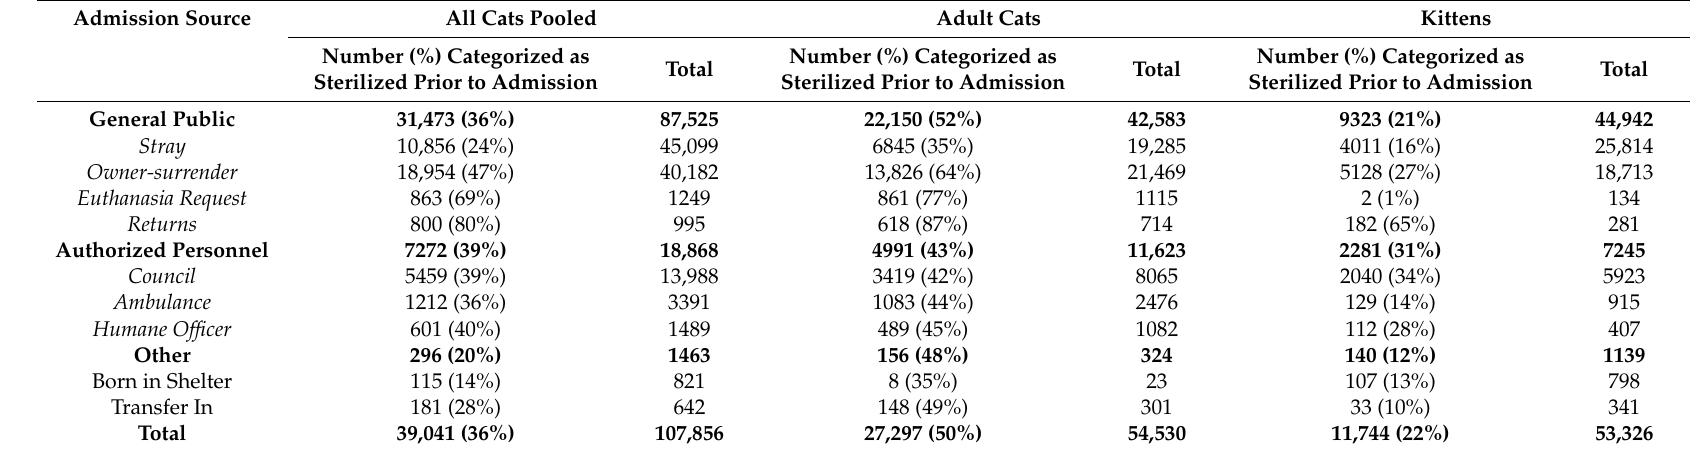
Table 5. Numbers and percentages of admissions to 39 RSPCA shelters between June 2006 and July 2010 where the cat was categorised as having been sterilized prior to admission, by admission mode and age. Only the 107,856 admissions where sterilization status prior to admission could be determined are